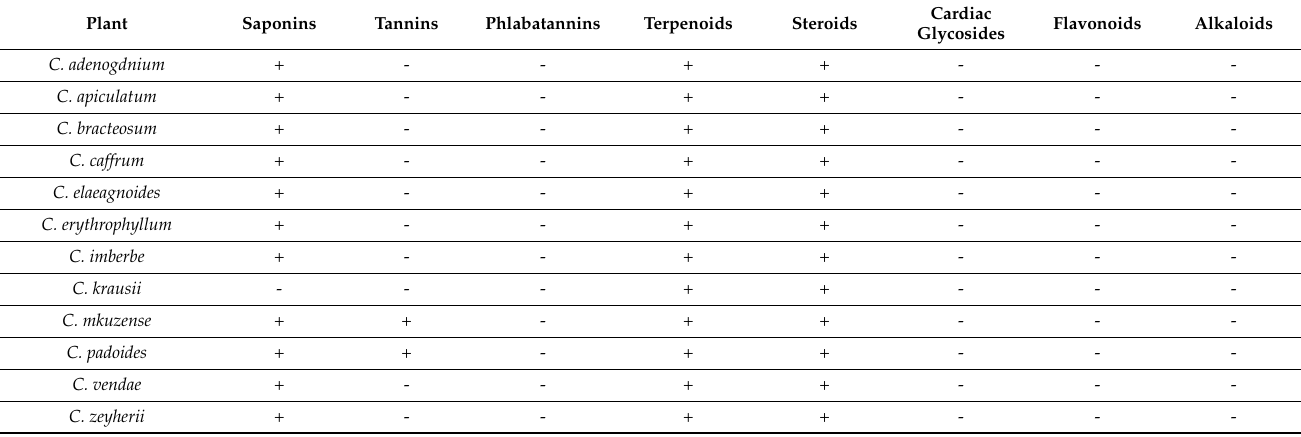
Table 3. Qualitative test for phytochemicals in the ashes of twelve Combretum species.